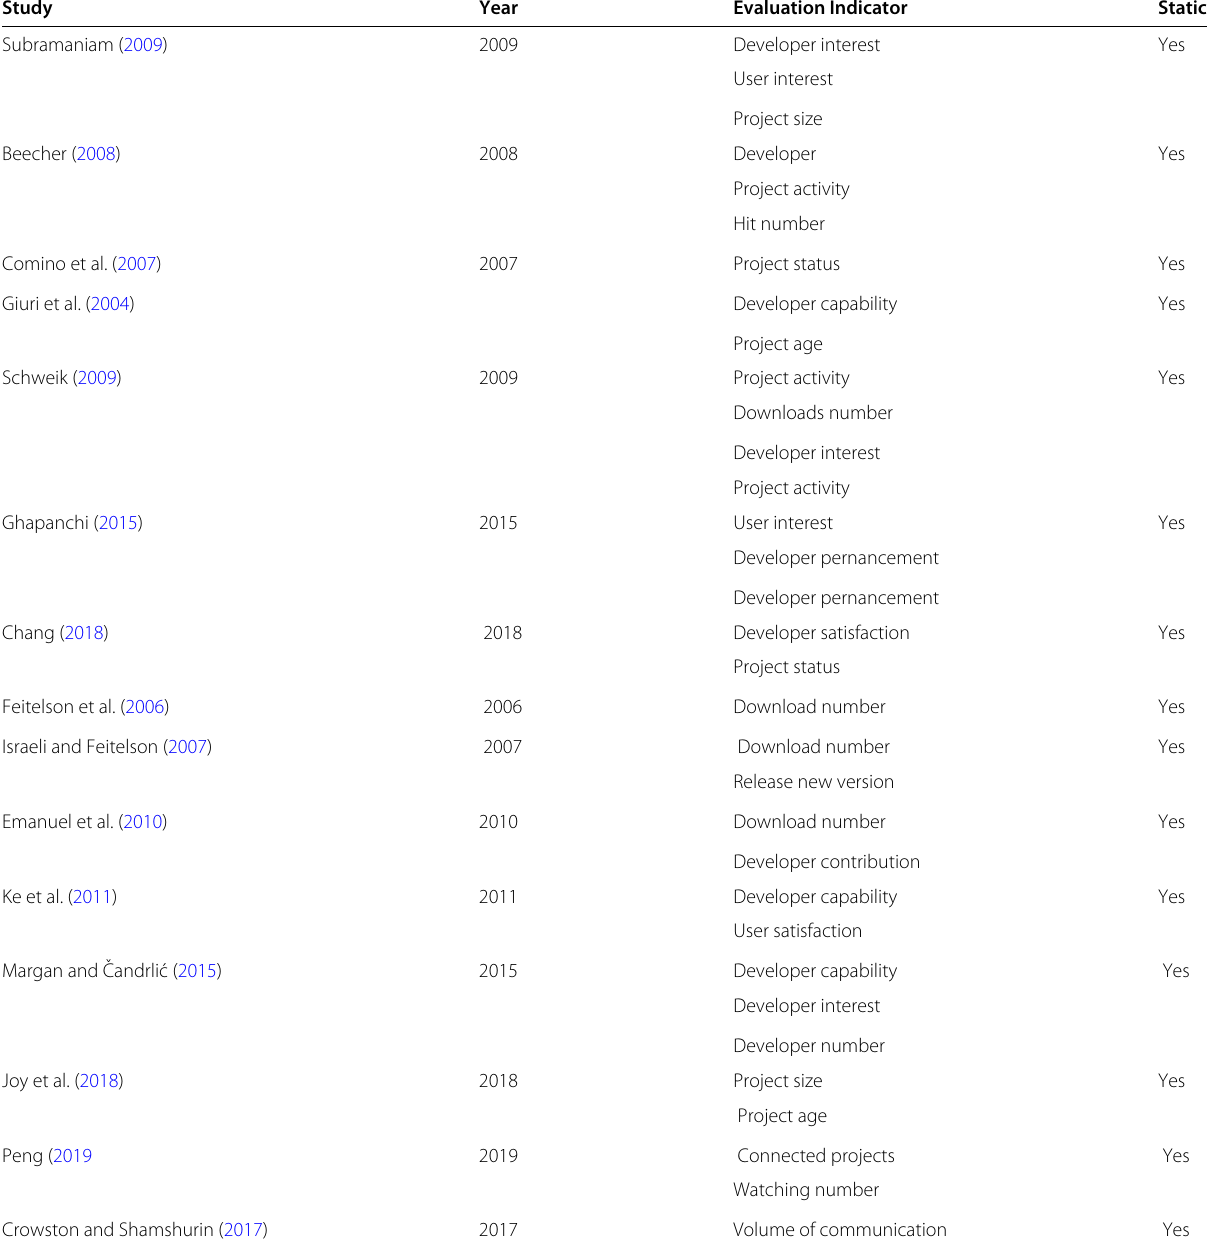
Table 2 OSS evaluation indicator proposed in the prior studies. “Evaluation Indicator” denotes the used evaluation indicators for investigation, “Static” indicates whether the authors used data at a single point to represent the whole time ( Continued